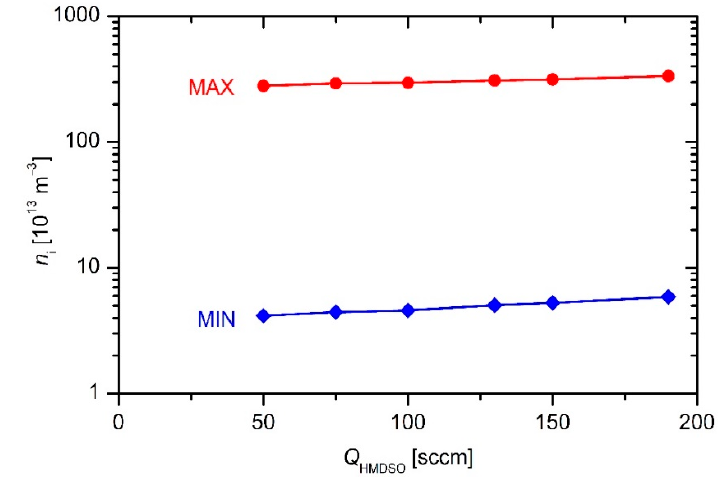
Figure 5. The limits of the plasma density in the industrial reactor versus the HMDSO flow at a discharge power of 3.4 kW.